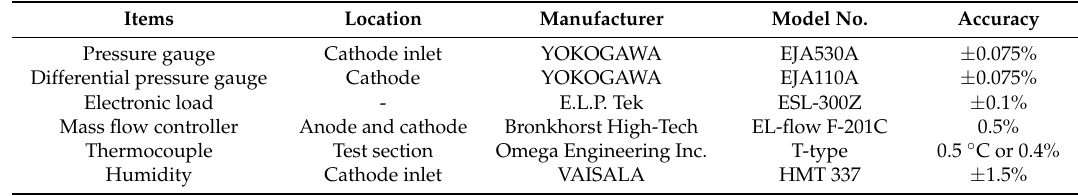
Table 1. Specifications of the measurement devices [18].